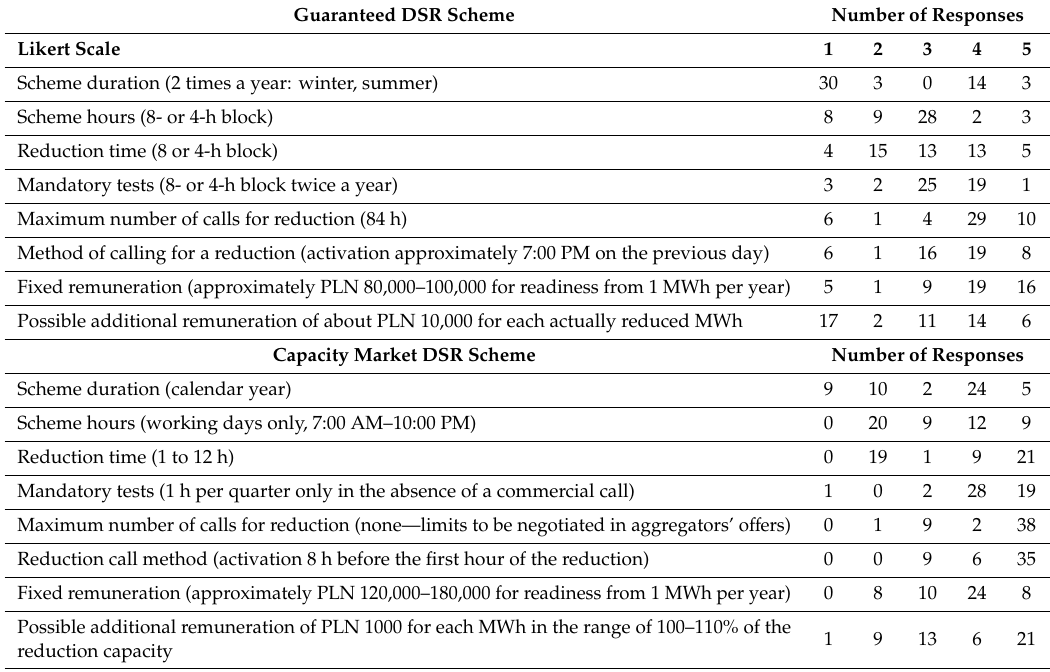
Table 3. Evaluation of the DSR